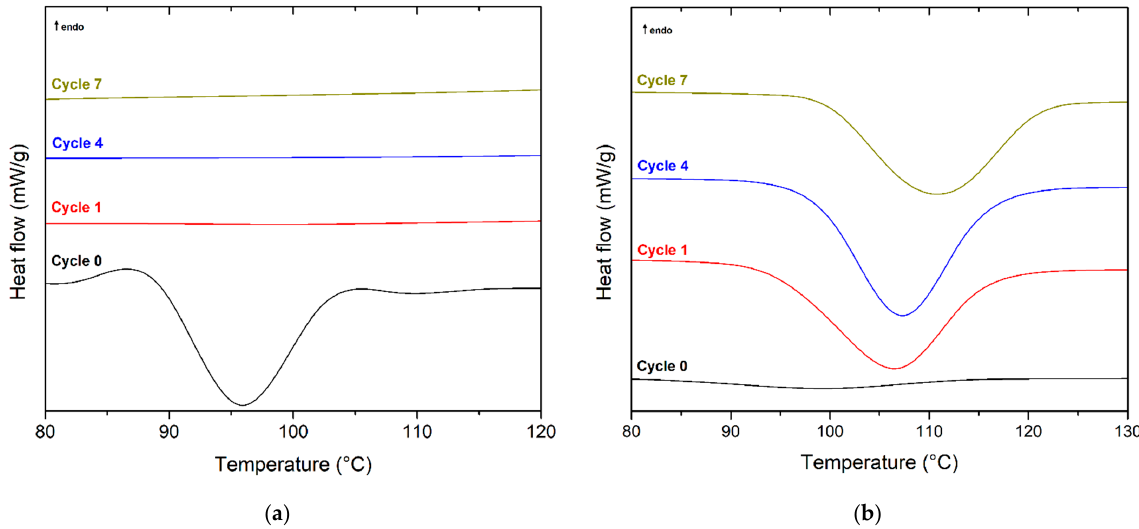
Figure 2. PLLA cold and melt crystallisation as a function of recycling cycle: ( a ) cold crystallisation (second heating); ( b ) melt crystallisation.